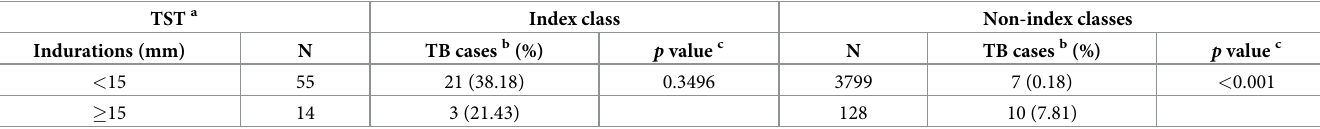
Table 4. Detection rates of TB cases with different TST indurations in different classes.